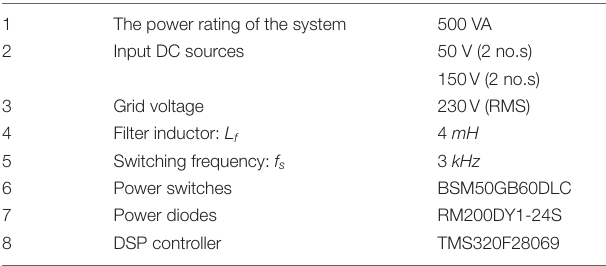
TABLE 4 | Parameters used in system evaluation of seventeen level inverter